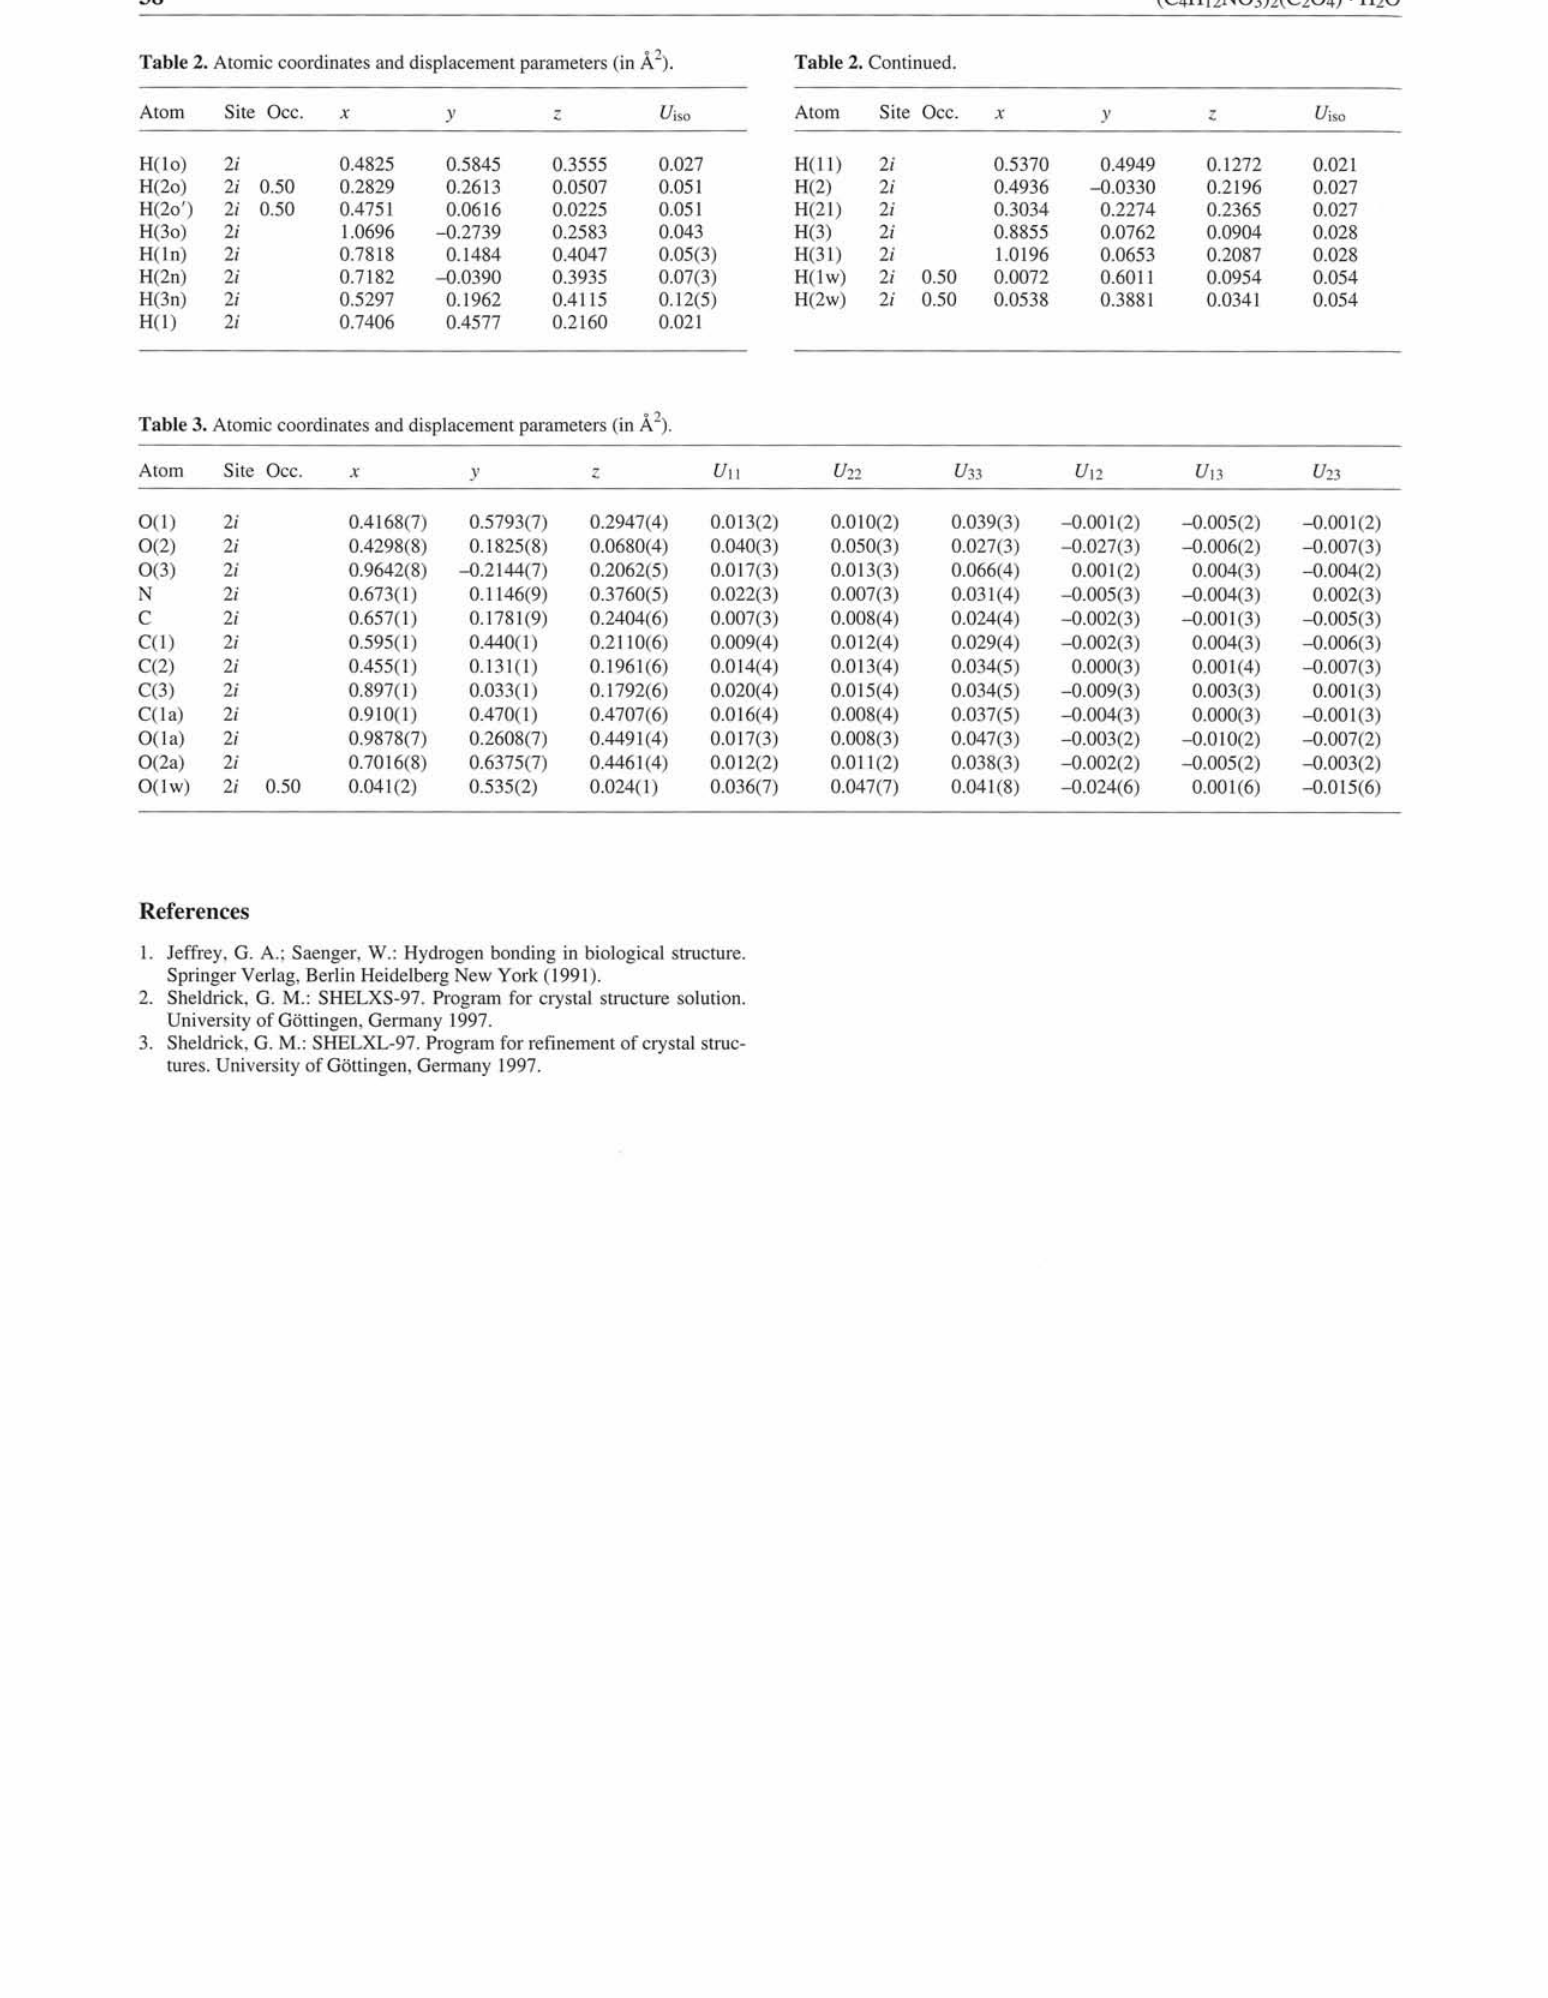
Table 2. Atomic coordinates and displacement parameters (in Â 2 ). Table 2. Continued.